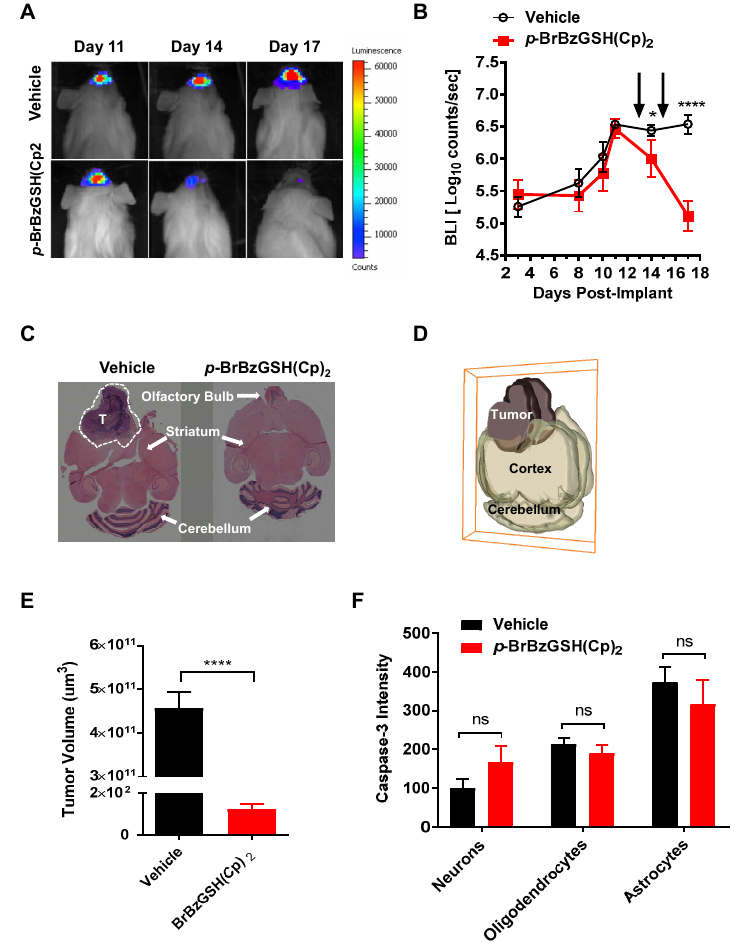
Figure 6. p -BrBzGSH(Cp) 2 decreased GBM tumor volume in mice. ( A ) Representative serial bioluminescence (BLI) acquisition; and ( B ) quantification over 17 days revealed significant reduction in BLI from xenografted GBM tumors in mice injected intraperitoneally with p -BrBzGSH(Cp) 2 vs. vehicle-treated mice ( n = 12 per group). Data are mean ± SEM, * p < 0.05, **** p < 0.0001, ns = not significant. Arrows indicate time of drug injections; ( C ) H&E brain slices of vehicle and p -BrBzGSH(Cp) 2 -treated mice 17 days post-implant. ( D ) 3D brain reconstruction for measuring tumor volume in vehicle-treated mice 17 days post-implant; ( E ) Tumor volume of vehicle and p -BrBzGSH(Cp) 2 treated mice 17 days post-implant; ( F ) Quantification of comparative immunofluorescence in vehicle and p -BrBzGSH(Cp) 2 treated animals revealed no increase in apoptotic marker Caspase-3 in neurons, oligodendrocytes, and astrocytes.